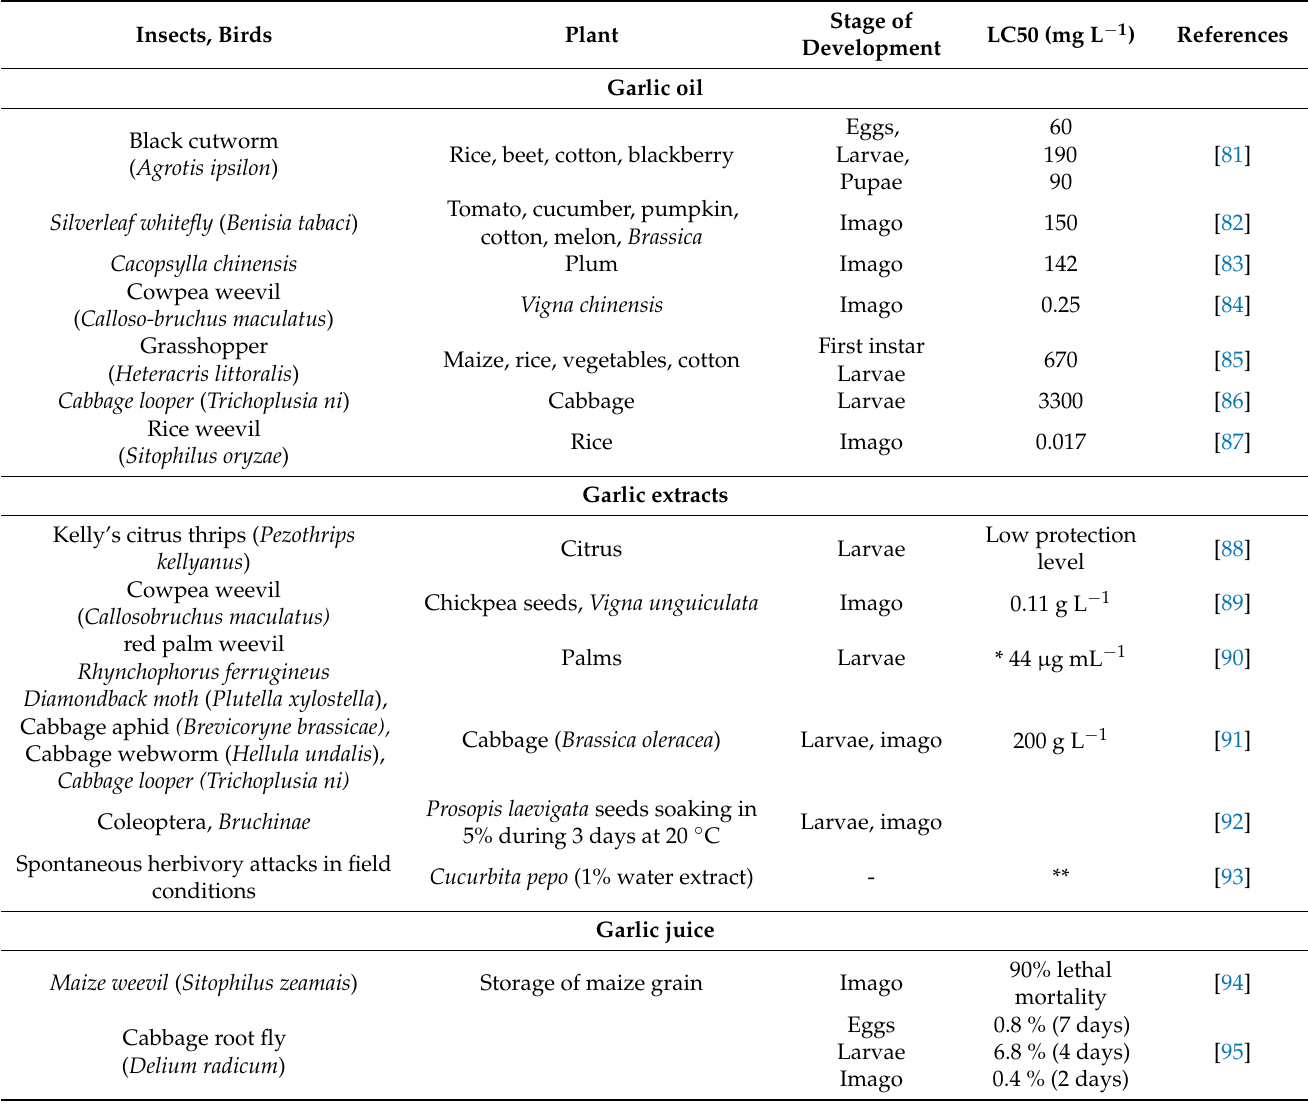
Table 1. Examples of garlic utilization against insect